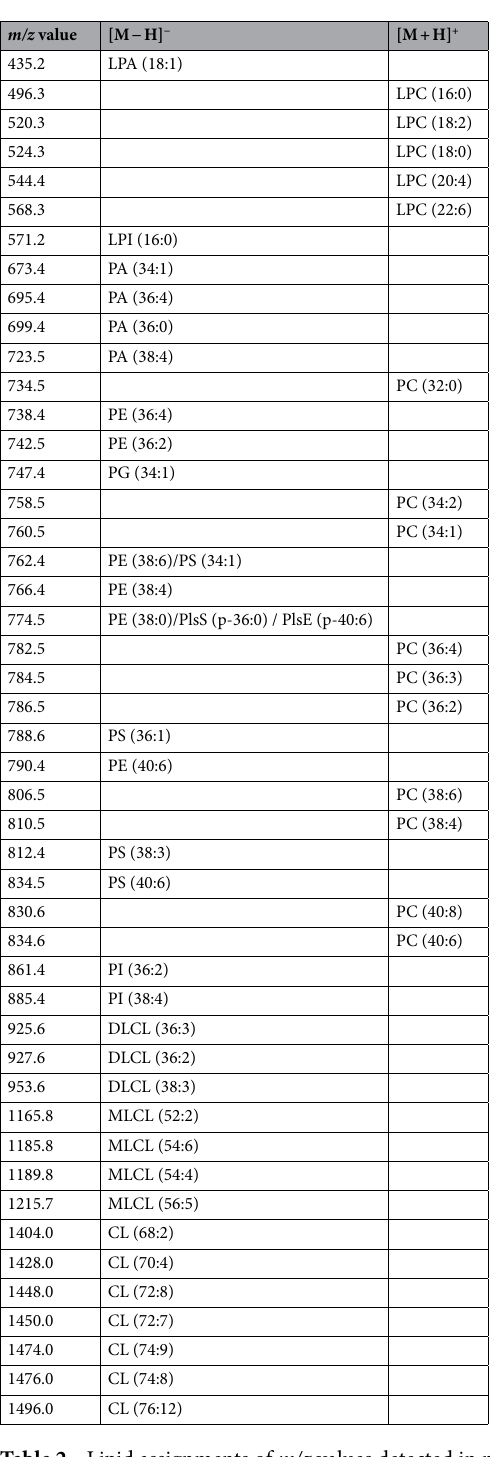
Table 2. Lipid assignments of m/z values detected in negative and positive ion mode MALDI-TOF mass spectra of heart mitochondria from WT and Taz KD mice. The numbers (a:b) define the total length (as carbon numbers) and number of double bonds of acyl chains,